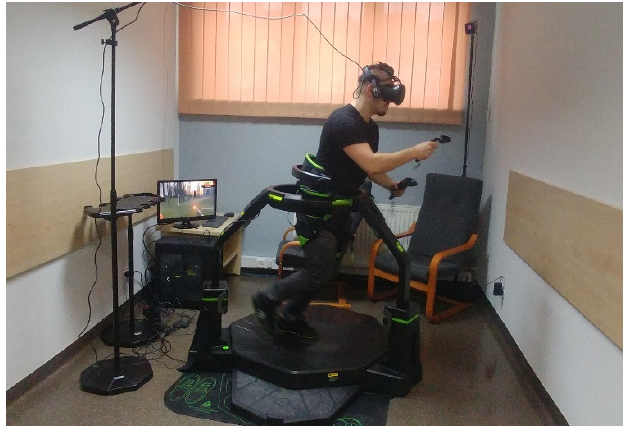
Figure 1. Omni-directional Omni treadmill enabling locomotive movements in virtual reality (VR). Source: author’s elaboration.